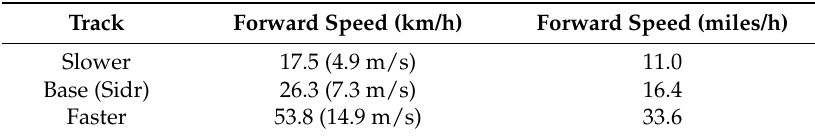
Table 2. Forward movement speed of three cyclone tracks being